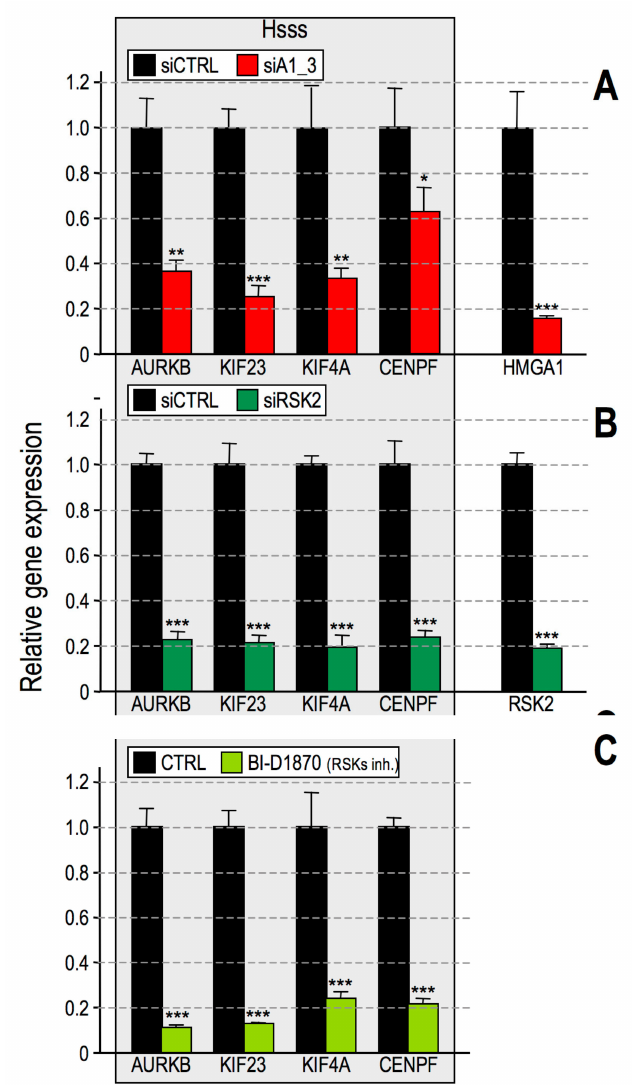
Figure 3. High Mobility Group A1 (HMGA1) and ribosomal protein S6 kinase alpha-3 (RSK2) regulate a common set of genes. Gene expression analyses performed by qRT-PCR on MDA-MB-231 cells transfected with ( A ) control (siCTRL) or HMGA1–targeting (siA1_3) small interfering RNAs, ( B ) control (siCTRL) or RSK2–targeting (siRSK2) siRNA, or ( C ) treated for 24 h with BI–D1870 10 µ M or dimethyl sulfoxide (CTRL) as a control. siRNA-treated cells were harvested after 72 h. Expression of the